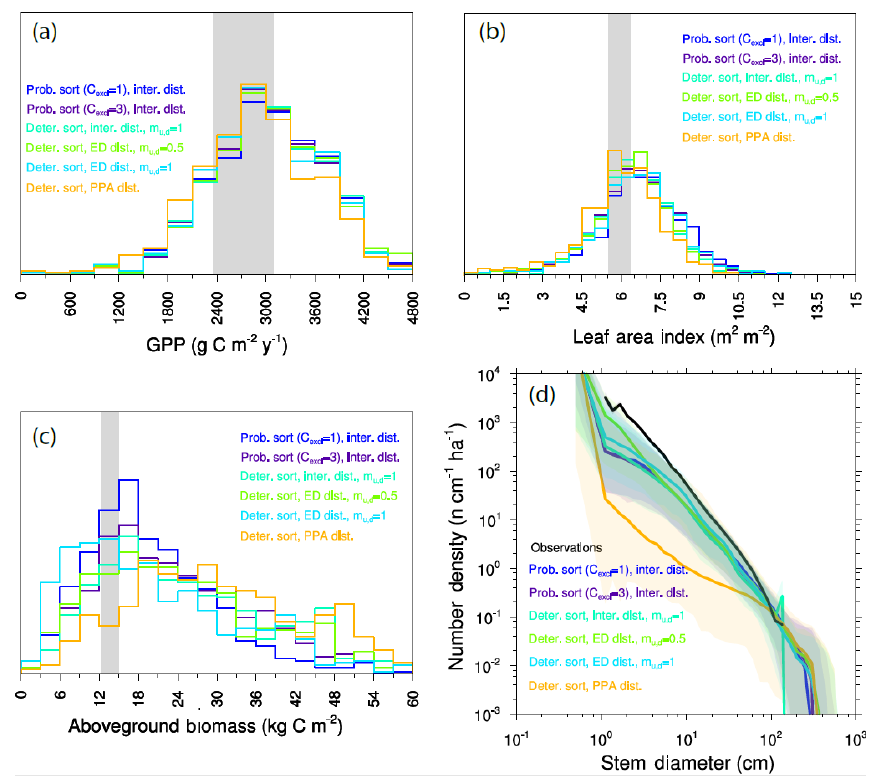
Figure 14. Ecosystem-level model results of paired PFT competition experiments. Ensemble distributions of (a) GPP, (b) LAI, (c) biomass, and (d) size distributions for each of the paired-PFT